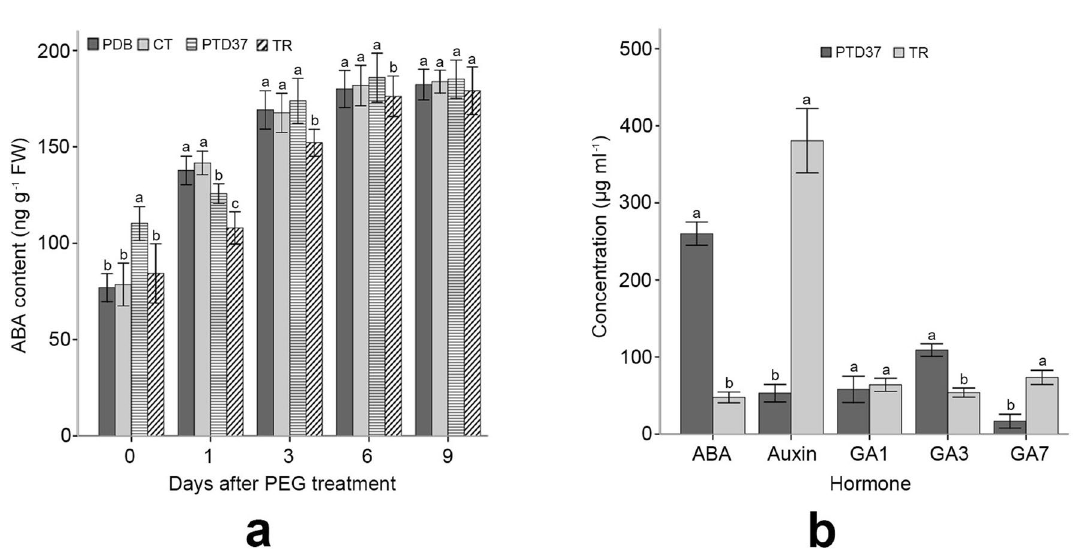
Figure 5. Effect of PEG application on the leaf ABA content of seedlings under different treatments and the levels of different hormones in PTD37 and T. harzianum fermentation broth. ( a ) Effect of PEG application on the leaf ABA content of seedlings under different treatments. ( b ) Levels of ABA, auxin, GA1, GA3 and GA7 in PTD37 and T. harzianum fermentation broth. PDB = potato dextrose broth; PTD37 fermentation broth supernatant of the PTD37 strain, TR fermentation broth supernatant of T. harzianum . Data are the means ± SD from five independent tests. Different letters on error bars indicate significant differences at P = 0.05 between the ABA contents of seedlings from different treatments on the same day after PEG application. They also indicate significant differences at P = 0.05 between the analyzed hormone levels of different fungal fermentation broths. The values on day 0 after PEG treatment indicate that they were measured before PEG